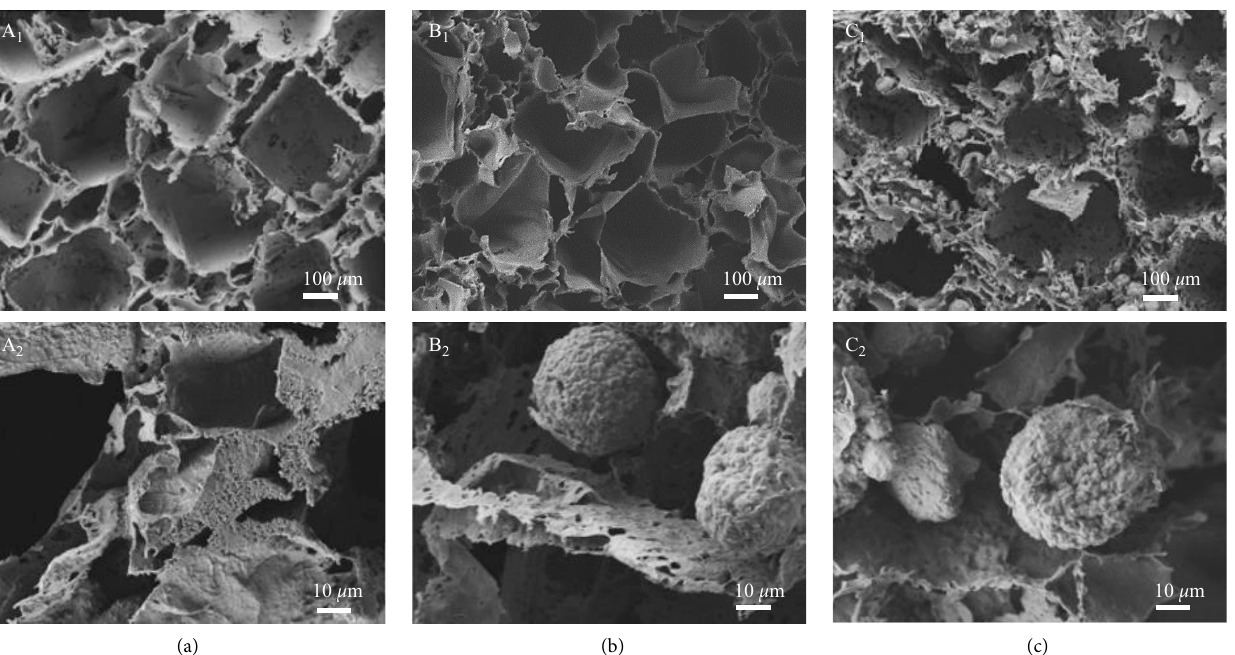
Figure 3: SEM images showing the INH-loaded b-PLGC scaffolds with different contents of microparticles. (a) INH/TCP/ b- PLGC scaffolds; (b) I-M/P50 scaffolds and (c) I-M/P70